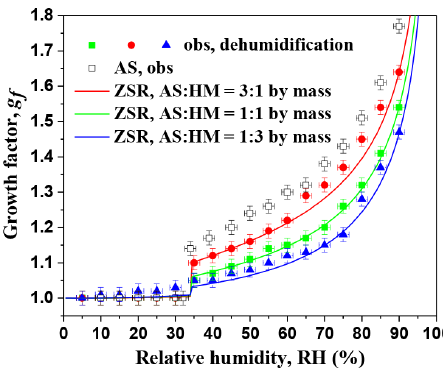
Figure 5. Hygroscopic growth factors and efflorescence of aerosol particles and constituents consisting of humic acid and ammonium sulfate at three different dry-state mass fractions with initial dry di- ameter of 100nm at RH < 5% as compared to that of pure ammo- nium sulfate (open symbols). Colored curves: ZSR predictions of diameter growth factors for dry particle compositions correspond- ing to the experimental data during dehumidification in the range from 90 to 5% RH at